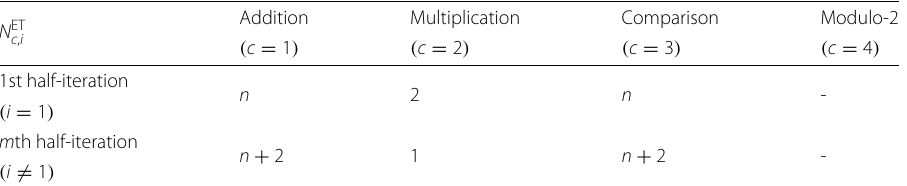
Table 5 The usage number of four arithmetic operators per half-iteration required in the proposed early termination